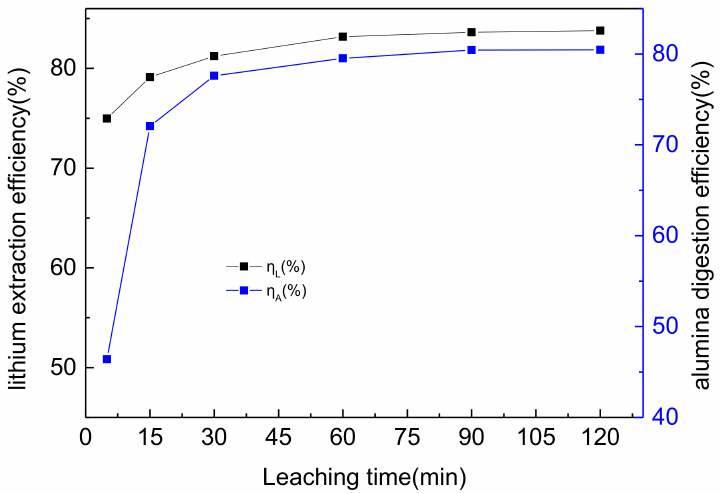
Figure 8. Effect of leaching time on lithium and alumina digestion of bauxite (conditions: ρ (K 2 O) = 254, mass ratio of CaO/ore = 8%, T = 265 ◦